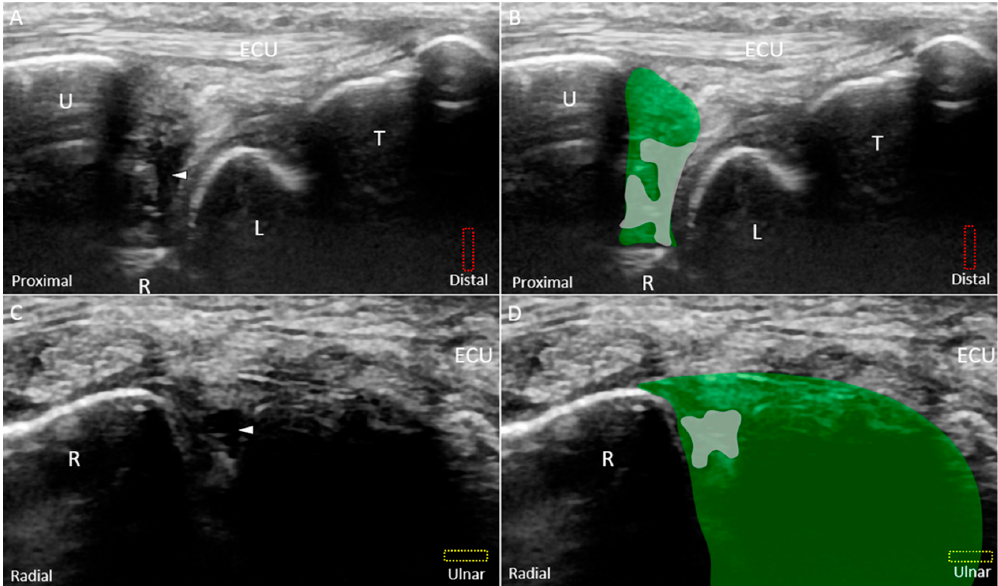
Figure 10. ( A ) US and ( B ) superposed US images using the long ‐ axis approach show a tear (white arrowhead and grey shade) of the disc (green) emerging from the radius, indicating Class 1C triangular fibrocartilage complex injury. ( C ) US and ( D ) superposed US images using the short ‐ axis approach in the same patient. The different color dashed rectangles are in accordance with the transducer positions in Figure 3. US: ultrasound; U: ulna; R: radius; L: lunate; T: triquetrum; ECU, extensor carpi ulnaris.